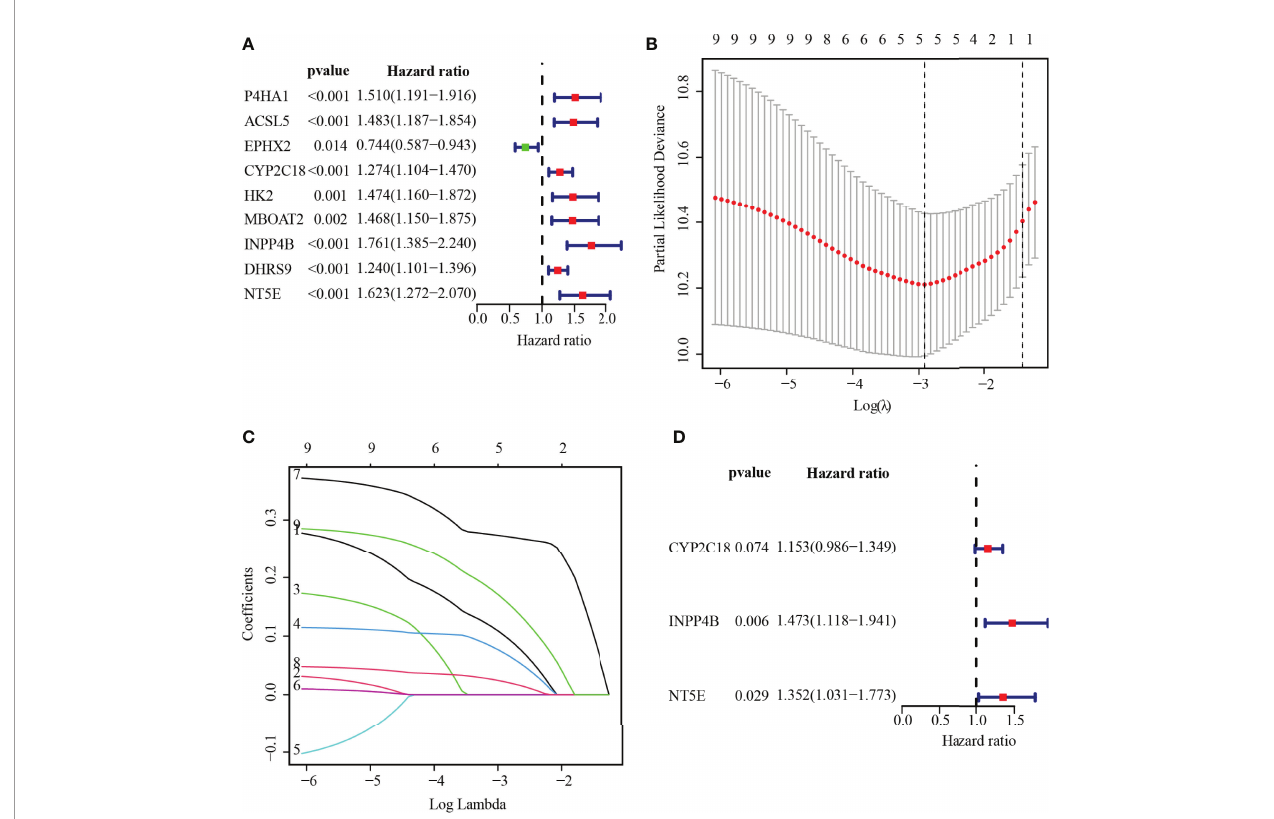
FIGURE 4 | Establishing MRGs prognostic signature. (A) Recognition of the outcome-related MRGs in PC via univariate Cox regression analysis. p < 0.01 were statistically meaningful. (B) The tuning parameter (lambda) is determined at the vertical line. (C) LASSO coef fi cient pro fi les of the 5-MRGs according to the tuning parameter. (D) The 3-MRG prognostic signature was built via multivariate Cox